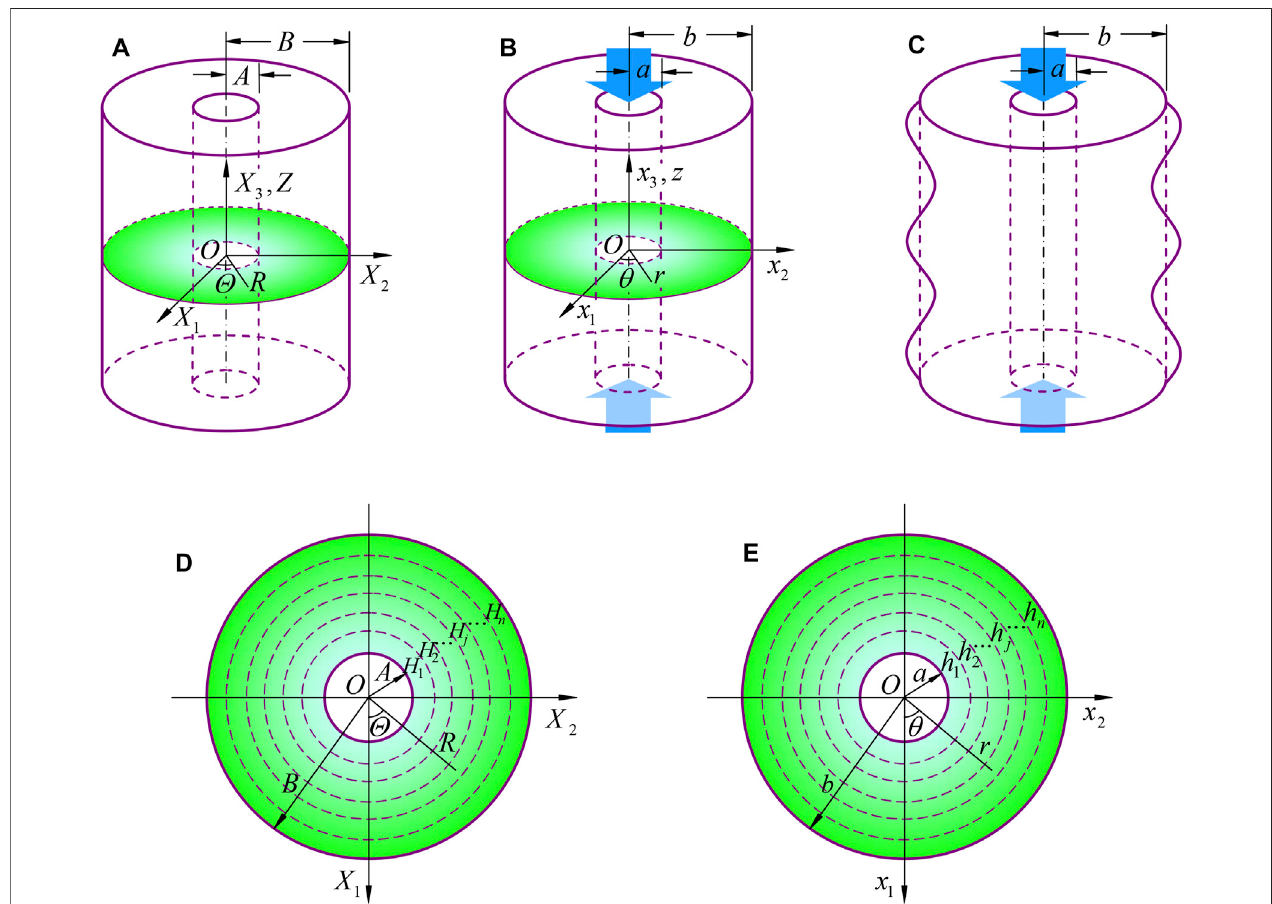
FIGURE 1 | Schematic illustrations for an elastic hollow cylinder: (A) in the stress-free reference state; (B) in the fundamental state subjected to axial compression; (C) in the axial wrinkling state; (D) and (E) divided into n cylindrical subshells in the reference and fundamental states for the state space analysis.